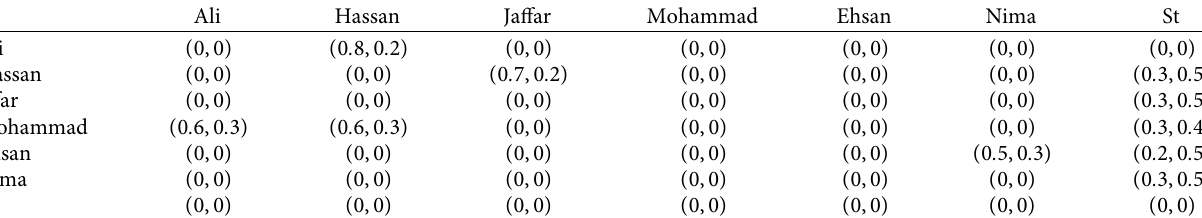
Table 4: Adjacency matrix corresponding to Figure